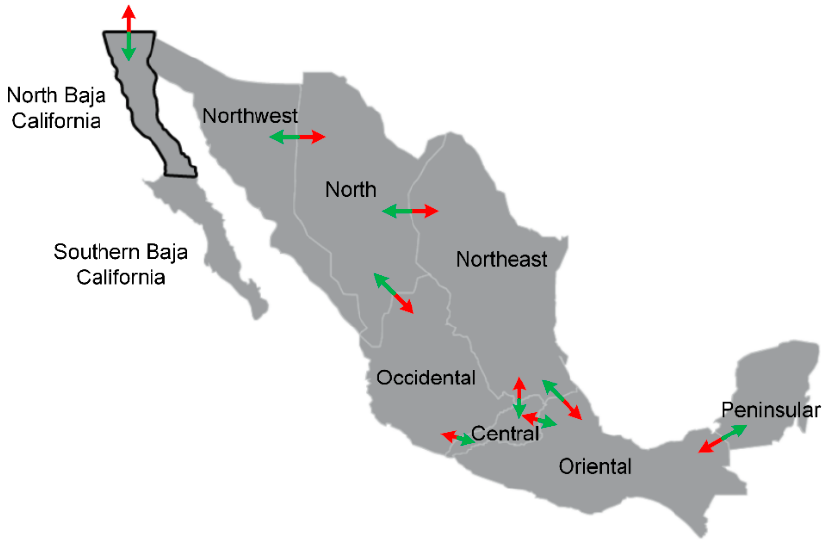
Figure 1. National Electric System distribution. Indeed, in the North Baja California region, being isolated, energy imports (from the United State of America, and up to 600 MW) are carried out to a greater extent, and energy exports to a much lesser extent. Table 1 shows the overall analysis for each region that composes the NES. In particular, net energy generation, net energy demand, and net energy exchange parameters were analyzed for each region. Thus, there are regions in which the net generation and net demand are similar; therefore, the net exchange is low, e.g., the North region. Regarding the Southern Baja California and North Baja California regions, because they are isolated regions, the deficit and surplus energy is self-managed. However, some regions have a net generation greater than the net demand. This implies that they export energy to other regions, e.g., Northeast and Oriental regions, exporting up to ≈ 3798 MW and ≈ 3605 MW, respectively. On the other hand, some regions have a net generation less than the net demand, so they must import energy, for example, North Baja California, Central, and other regions. It is important to mention that, generally, the NES is based on centralized power generation and, to a lesser extent, on distributed power generation, i.e., distributed power generation only represents ≈ 4% of the installed power capacity. Therefore, the net generation at a national level is ≈ 80